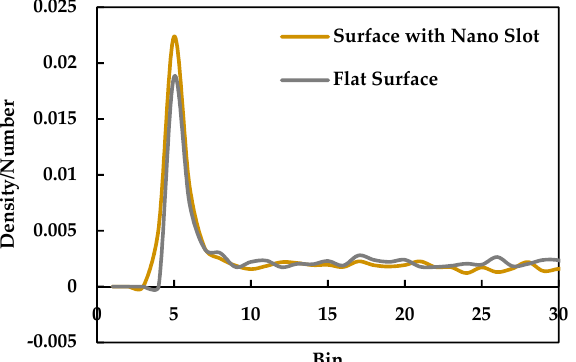
Figure 15. Comparison of temperature history of the argon atoms for a surface having nano slots with a smooth surface.